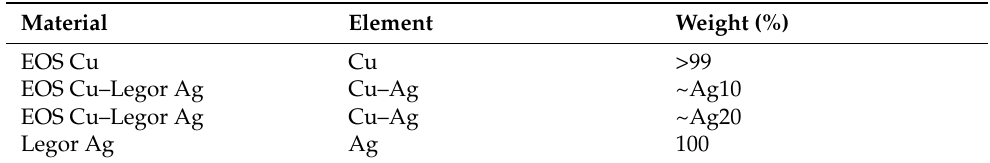
Table 5. Material composition of silver addition study.